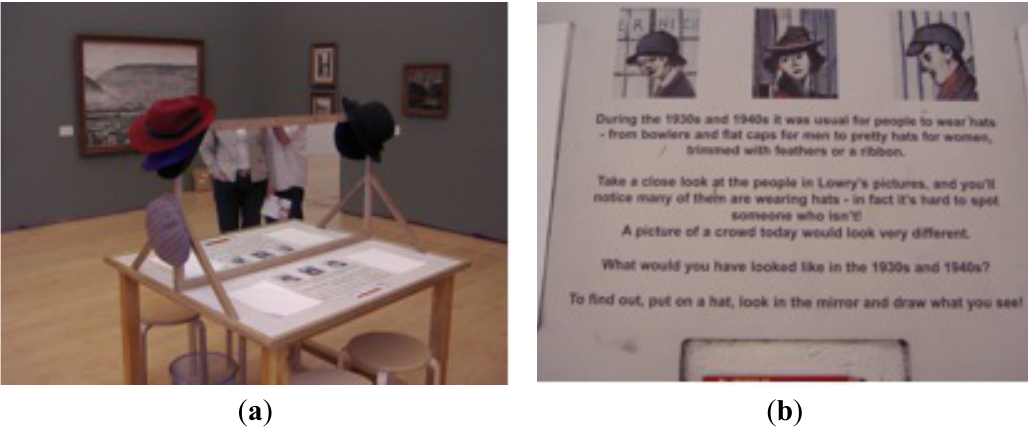
Figure 4. ( a ) Mirror and ‘dress-up’ clothes. Source: author. ( b ) Instructions. Source: